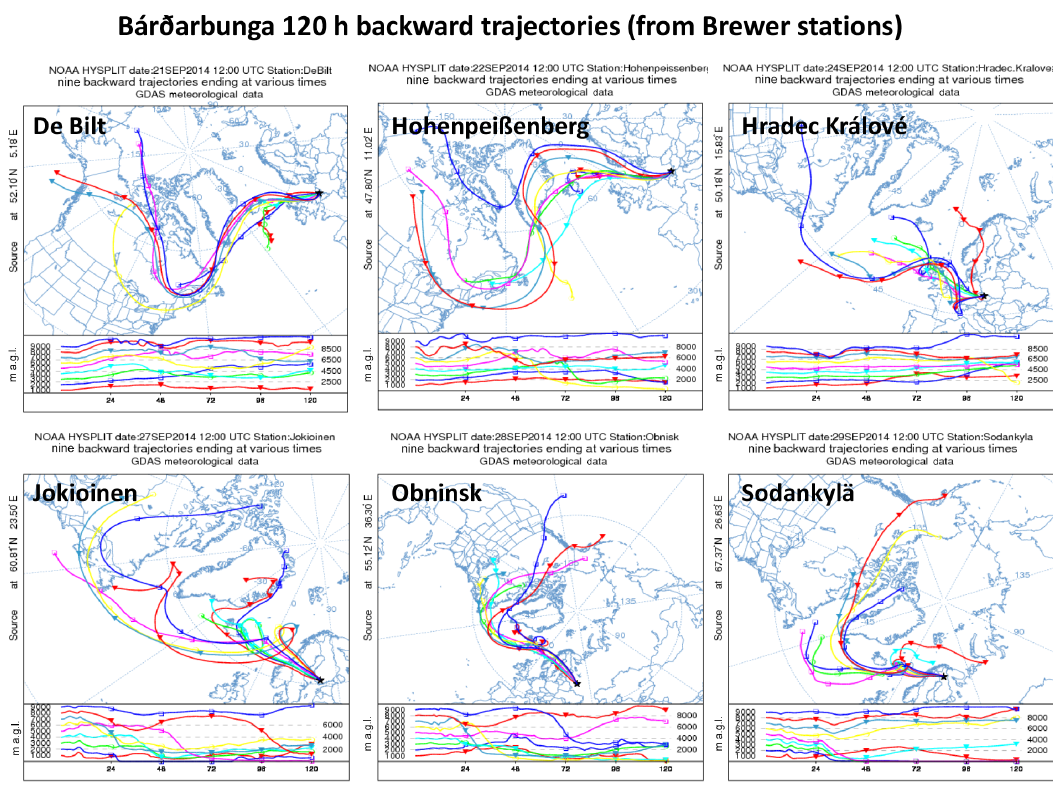
Figure 3. HYSPLIT 120h back trajectories of air masses arriving on the day of maximum SO 2 records for each of the Brewer stations at De Bilt, Hohenpeißenberg, Hradec Králové, Jokioinen, Obninsk and Sodankylä.